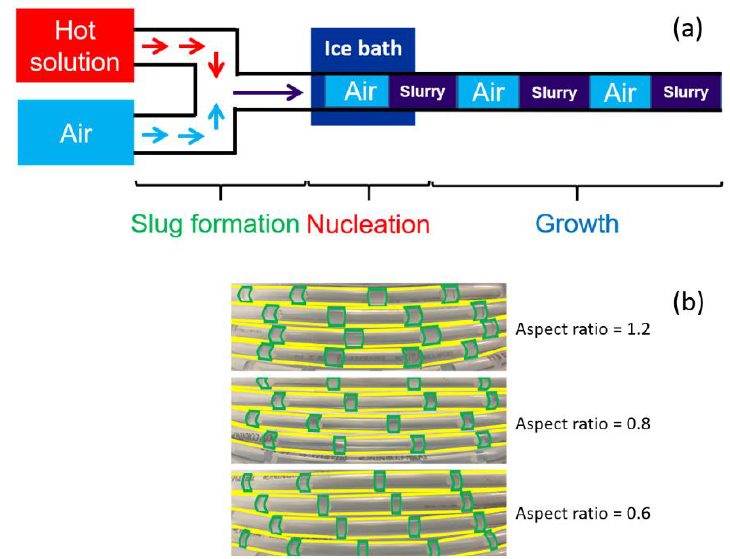
Figure 1. ( a ) Schematic of the slug-flow cooling crystallization process. Slugs form by combining glycine solution and air streams at proper flow rates. Nucleation is induced by crash cooling of glycine solution slugs through tubing wall (from ice bags). The nucleation region is not necessarily only in the ice bags. ( b ) Photos of packed crystallizers, with different aspect ratios of liquid slugs (slug boundary highlighted in green).